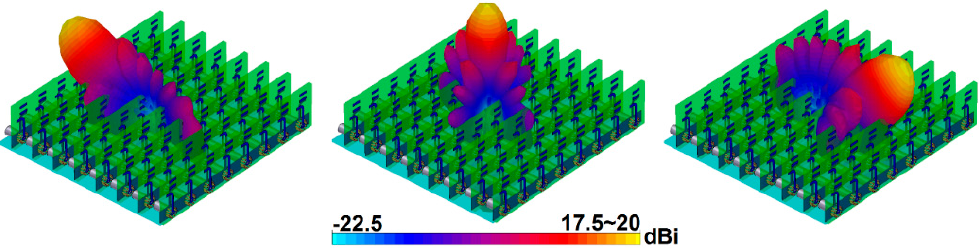
Figure 19. Configuration and 3D beams of the Quasi-Yagi phased array at different angles.